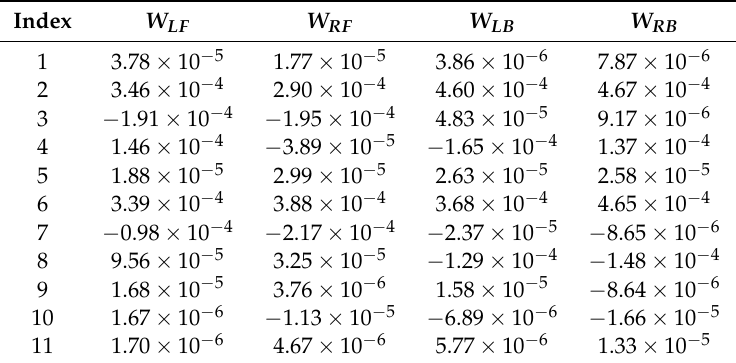
Table 4. Weight vector table.